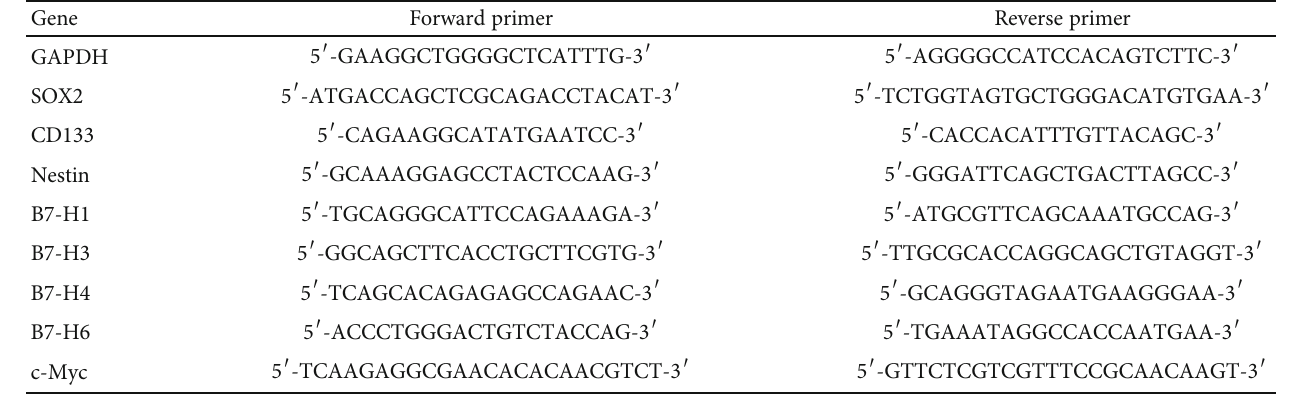
Table 1: Primer sequence for real-time PCR.